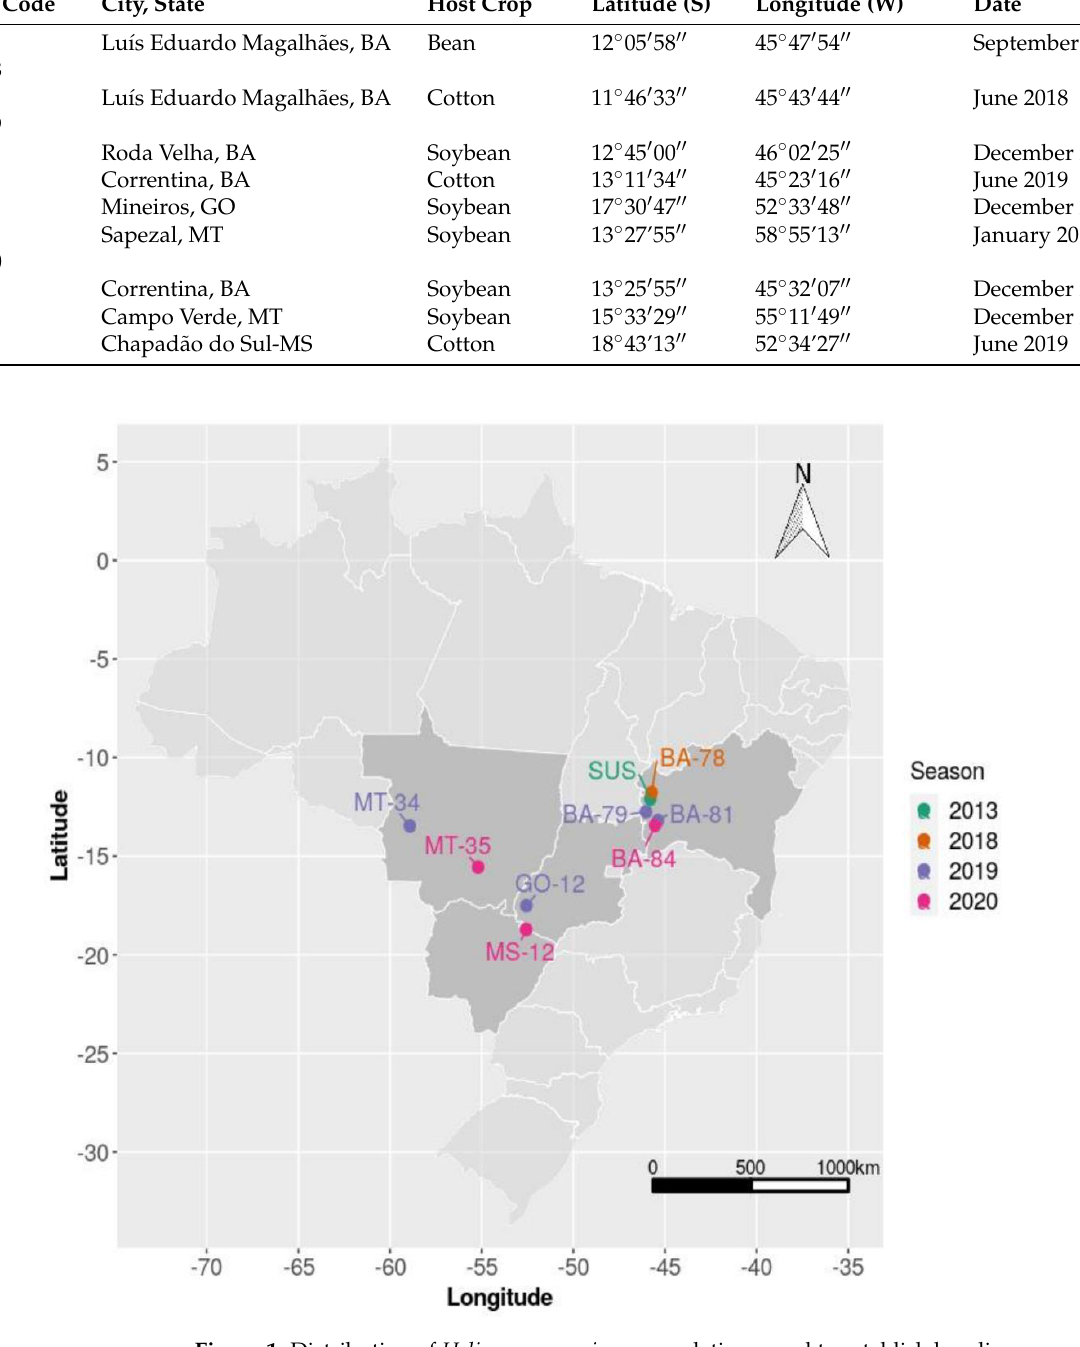
Figure 1. Distribution of Helicoverpa armigera populations used to establish baseline susceptibility to HearNPV and validation of a diagnostic concentration. Table 1. Populations of Helicoverpa armigera used for the characterization of the baseline susceptibil- ity and validation of the diagnostic concentration to HearNPV.